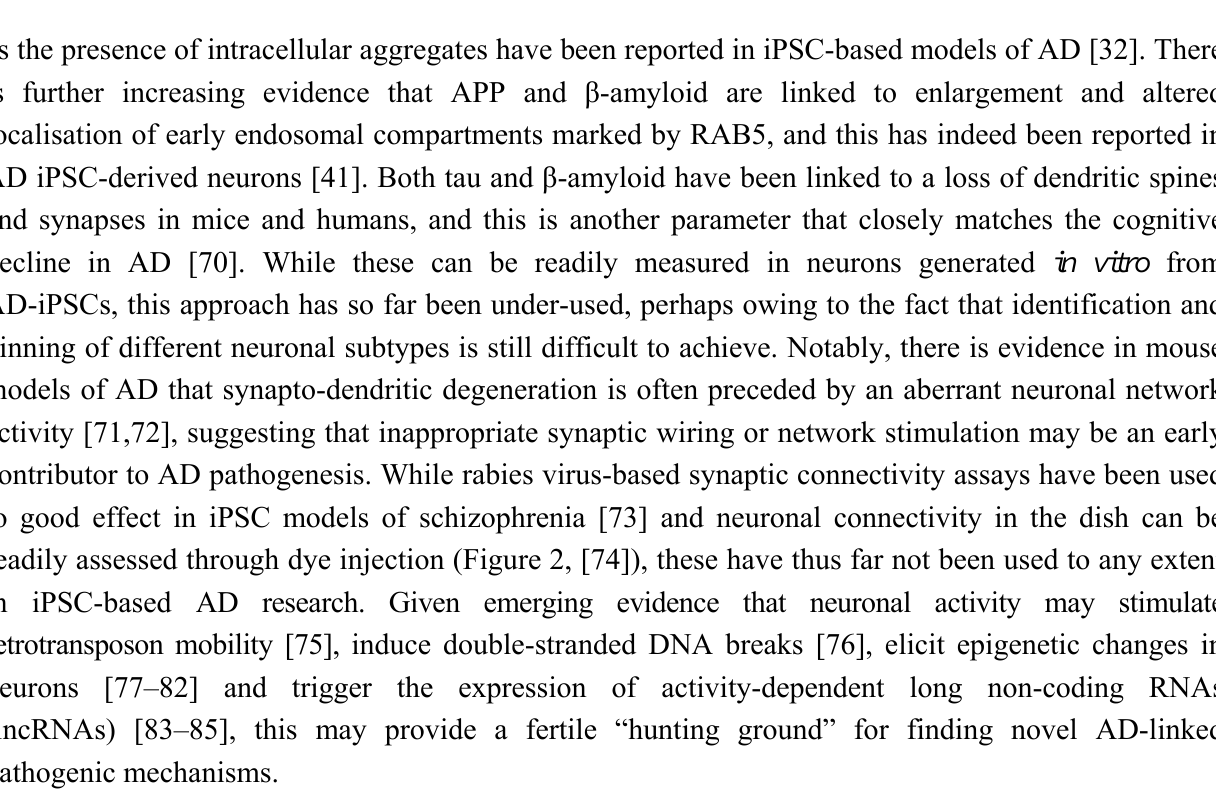
Figure 2. A Day 70 neuronal culture from control iPSCs, imaged 30 min after one cell was micro-injected with NeuroBiotin™ and detected using Streptavidin-Cy3, reveals the highly interconnected nature of neurons and astrocytes generated in vitro . Image courtesy